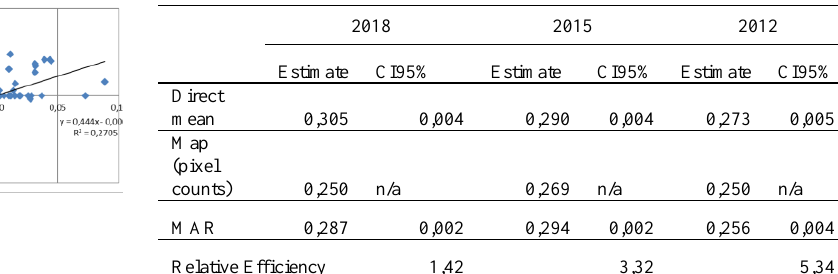
Figure 5: Illustration of the importance of the quality of the linear regression with (a) all observations and (b) one observation